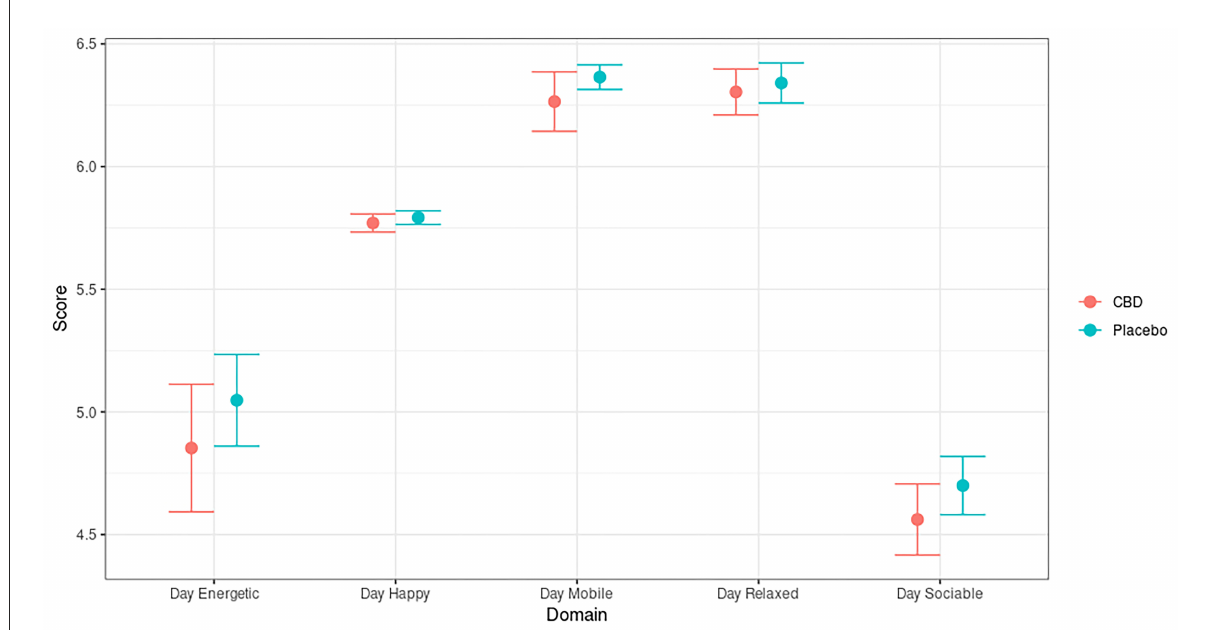
FIGURE1 Daily quality of life (QoL) assessment across five domains in dogs dosed with CBD (red) and placebo (blue), where a score of 7 is a maximum and 1 is a minimum possible value for each domain. Values represent mean and 95% confidence intervals of 1,001 surveys from the CBD group, and 1,097 surveys from the placebo